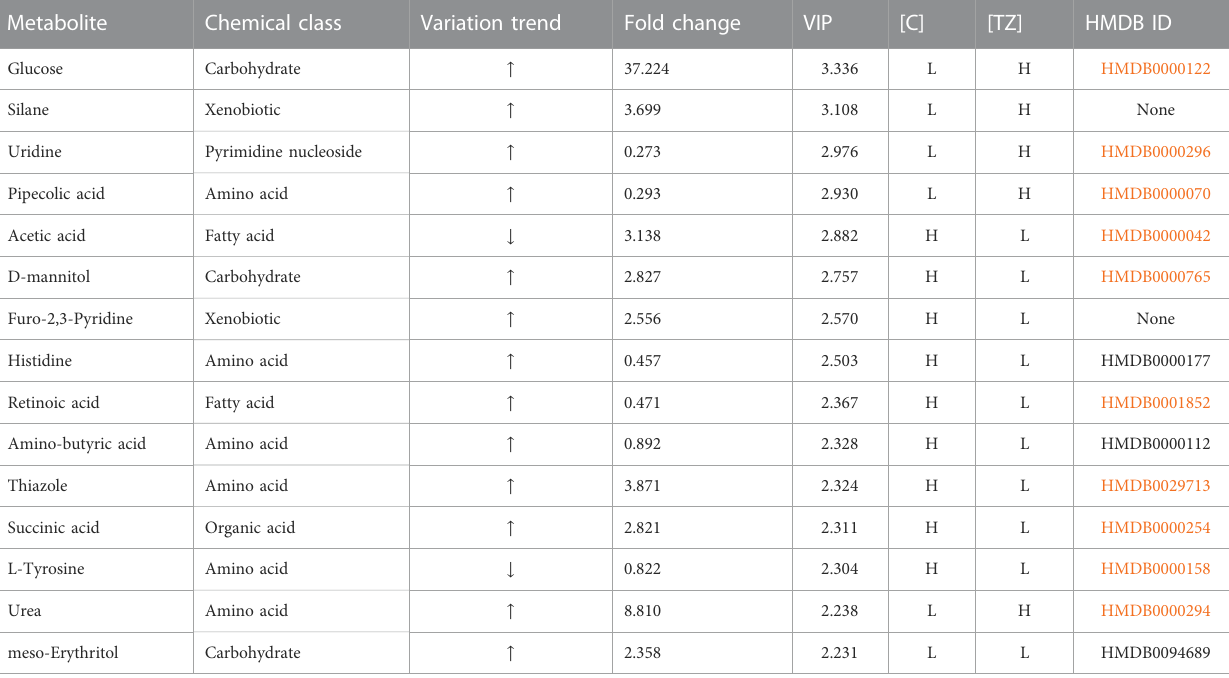
TABLE 1 Quantitative comparison of the potential biomarkers identi fi ed from the serum samples of Sprague Dawley rats infected with Trichinella zimbabwensis and the uninfected control group.